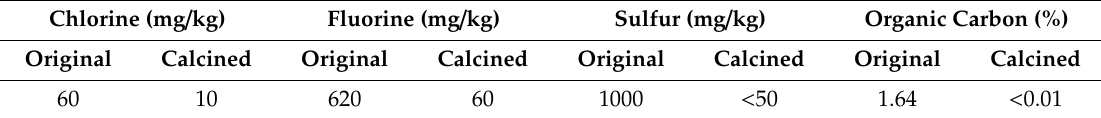
Table 3. Determined values of chlorine, fluorine, sulfur and organic carbon in the sample BCS-CRM 348.